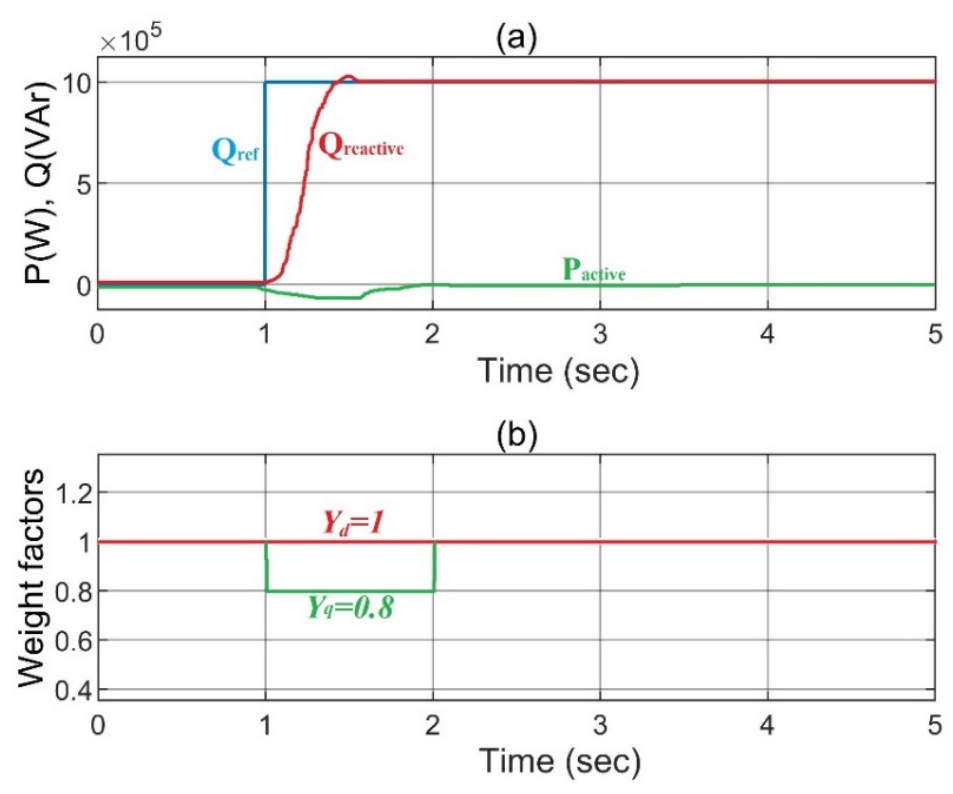
Figure 11. Step response of FCS-MPC during variable WFs. ( a ) Active and Reactive power ( b ) Dynamics of WFs.